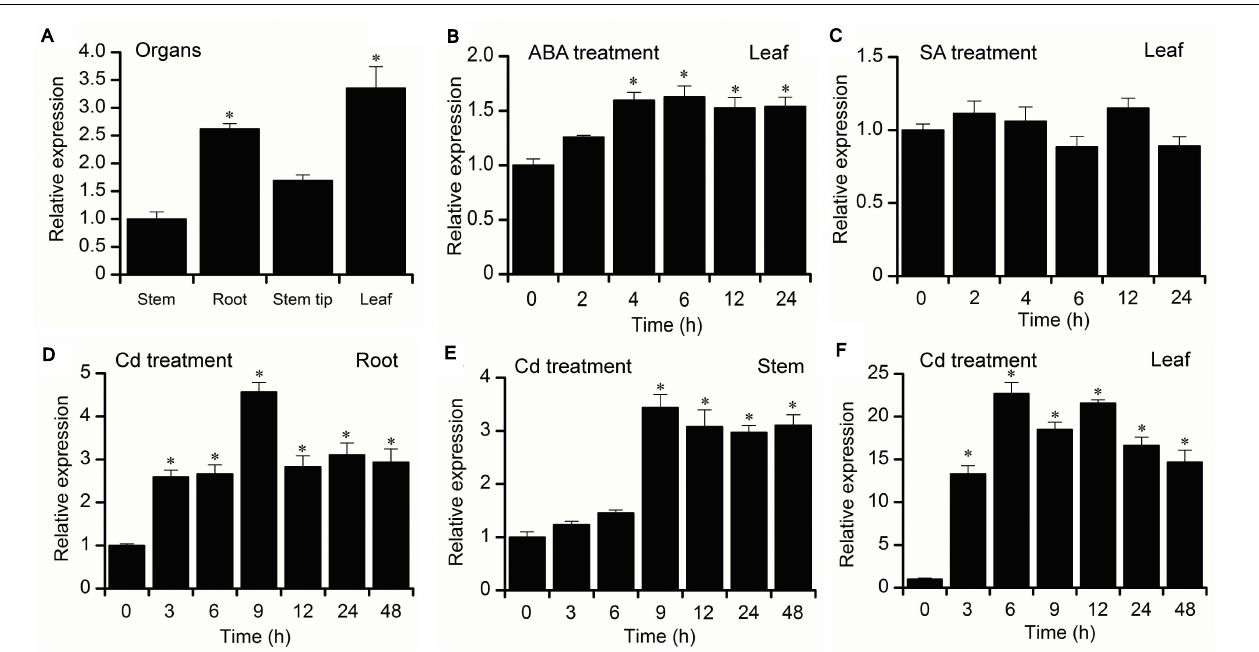
FIGURE 3 | Expression pattern of BnPCS1 . (A) qRT-PCR analysis of BnPCS1 mRNA levels in the roots, stems, stem tips, and leaves of 21-day-old B. nivea seedlings. (B,C) BnPCS1 expression levels in the leaves of B. nivea seedlings treated with 100 µ M ABA (B) or 1 mM SA (C) for 0, 2, 4, 6, 12, and 24 h. (D–F) : BnPCS1 expression levels in the roots (D) ,stems (E) , and leaves (F) of B. nivea seedlings treated with 200 µ M Cd for 0, 3, 6, 9, 12, 24, and 48 h. Data are presented as the means of three biological replicates with SE shown by vertical bars. Asterisks indicate significant differences ( p < 0.05) between the treatment groups and the